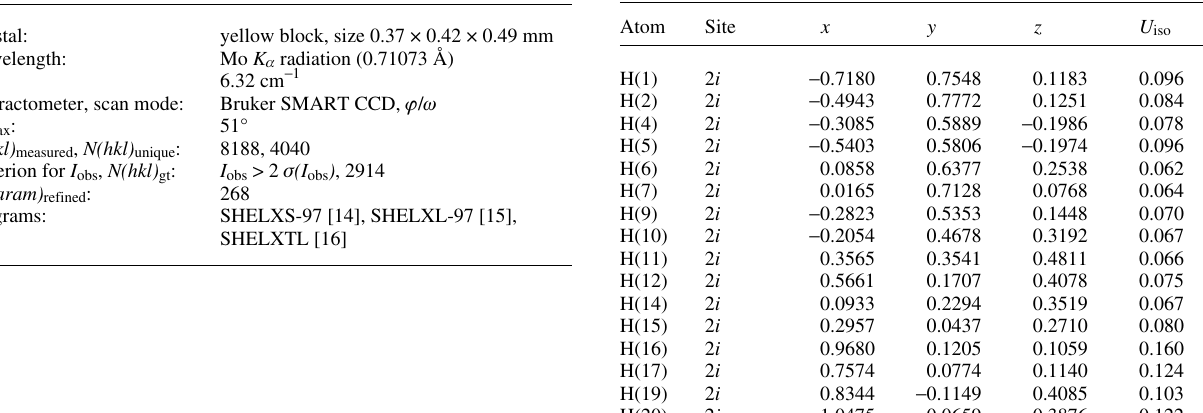
Table 2. Atomic coordinates and displacement parameters (in Å 2 ) . Table 1. Data collection and